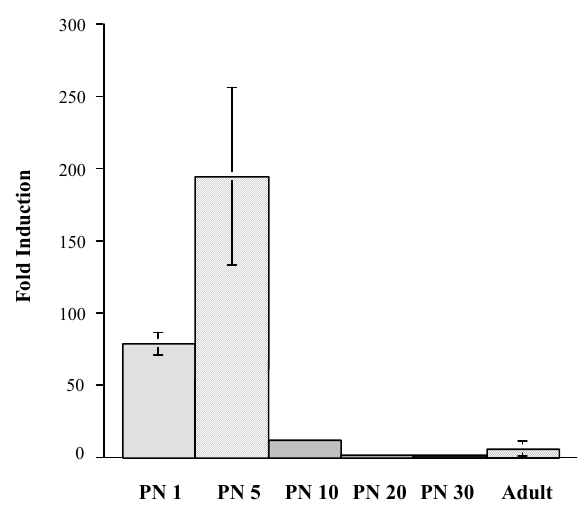
FIGURE 1 . Real time PCR determinations[17] on developing postnatal (PN day 1–30) rat kidneys to quantify levels of amylin mRNA relative to adult kidney.